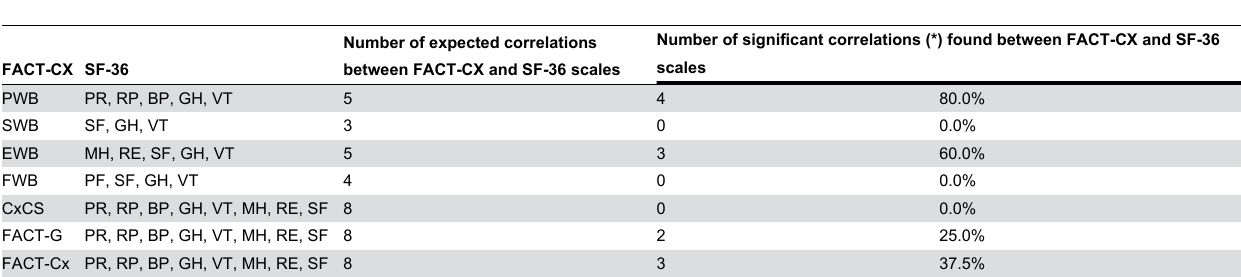
Number of significant correlations (*) found between FACT-CX and